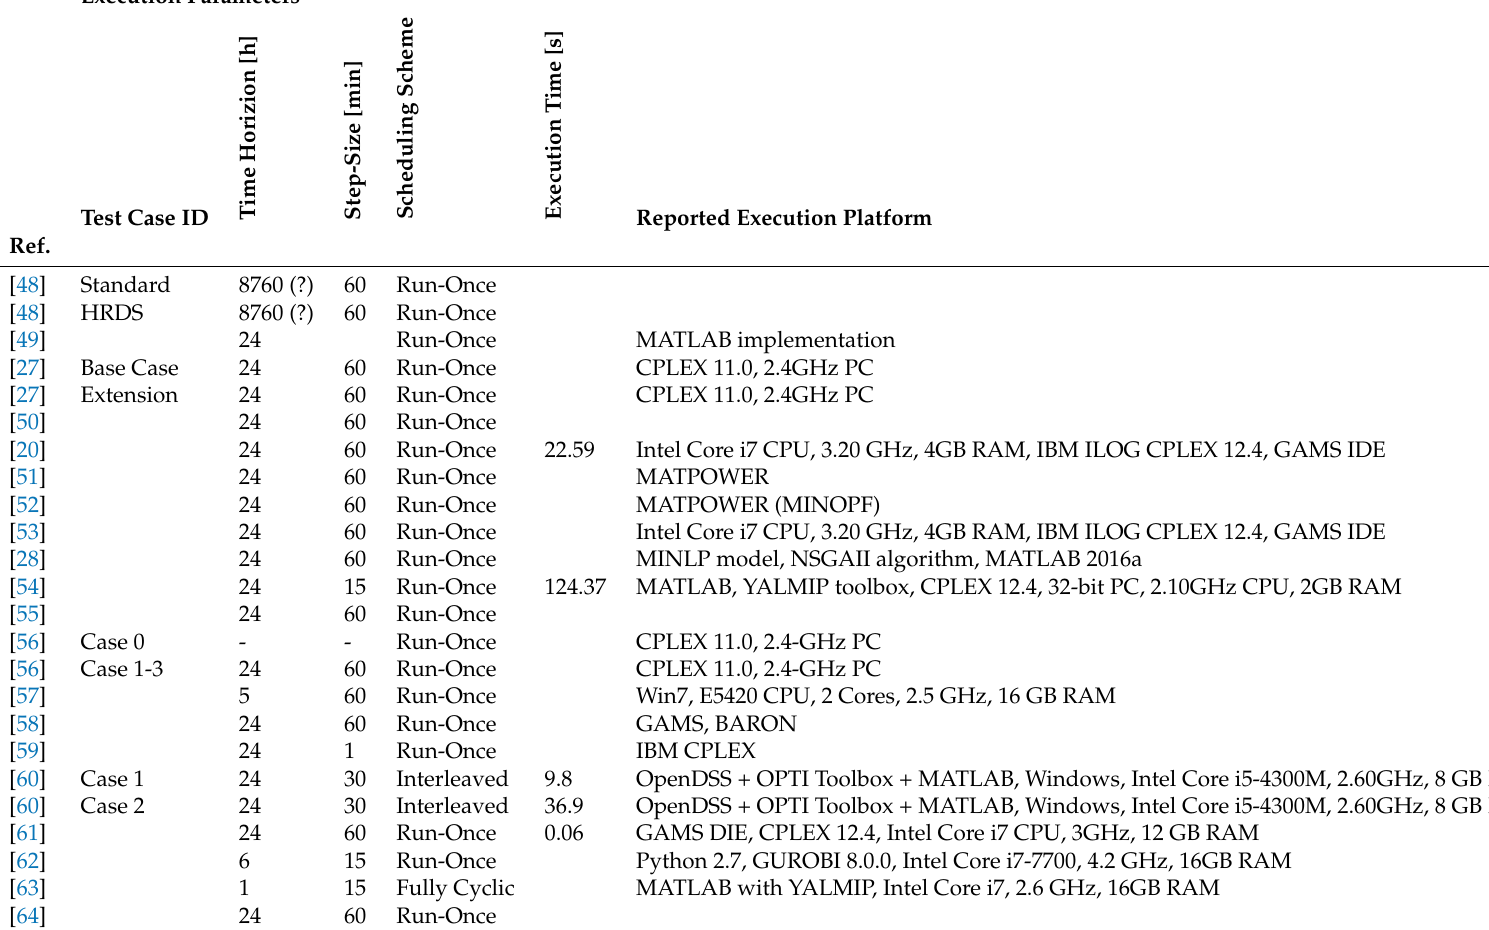
Table 9. Validation platform (?: Not